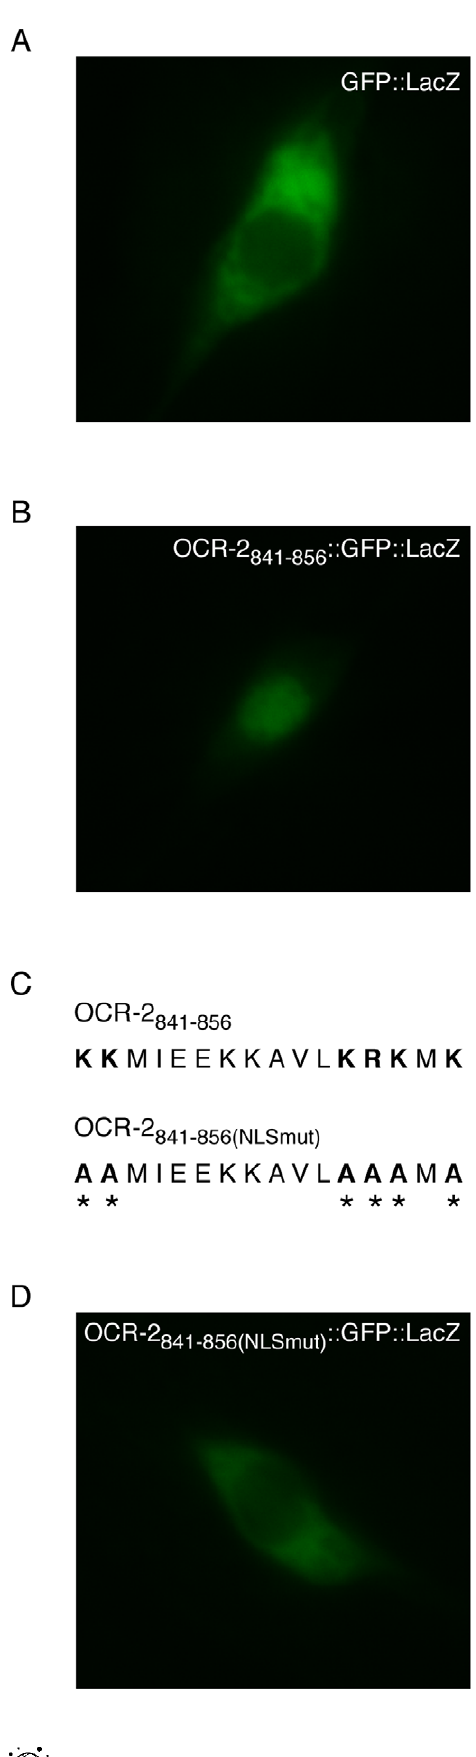
Figure 2. The putative NLS in OCR-2 is sufficient to drive nuclear localization of a GFP::LacZ fusion protein, and requires basic residues within the NLS. The osm-10 promoter [30] was used to express GFP::LacZ fusion proteins in the ASH neurons. (A) The GFP::LacZ fusion ( osm-10p::gfp::lacZ ) alone is excluded from the nucleus of the ASH neurons. GFP fluorescence was restricted to the cytoplasm in 78/78 animals assessed. (B) Inclusion of the putative NLS, upstream of and in frame with GFP::LacZ ( osm-10p::ocr-2 841–856 ::gfp::lacZ ), resulted in robust nuclear translocation of GFP. The ASH neurons of 97/103 worms examined displayed pronounced nuclear accumulation of GFP. (C) Six of the basic lysine and arginine residues (indicated in bold) were replaced with the nonpolar amino acid alanine (indicated with an asterisk and in bold) and the mutated NLS was fused upstream of and in frame with GFP::LacZ ( osm-10p::ocr-2 841–856(NLSmut) ::gfp::lacZ ). (D) Mutating these basic clusters abolished nuclear localization. The OCR-2 841–856(NLSmut) ::GF- P::LacZ fusion was restricted to the cytoplasm of ASH in 44/44 animals examined. Numbers represent the combined data of $ 3 independent transgenic lines for each